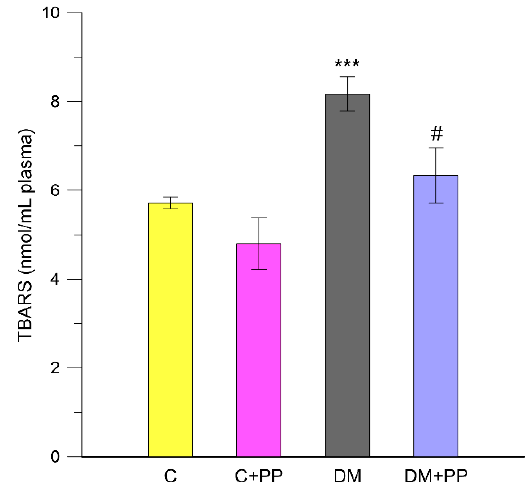
Figure 3. Effects of purple potato (PP) extract from Blue Congo (daily dose of 165 mg/kg b.w. for 14 days) on the content of thiobarbituric acid (TBA)-reactive substances (TBARS) of lipid peroxidation (LPO) in the blood plasma of rats. C – control group, C + PP—control rats receiving extract from Blue Congo, DM—diabetic group, DM + PP—diabetic rats treated with Blue Congo extract. The results are shown as means ± SD. Designations: *** p < 0.001 compared to the control group; # p < 0.05 compared to the DM group.